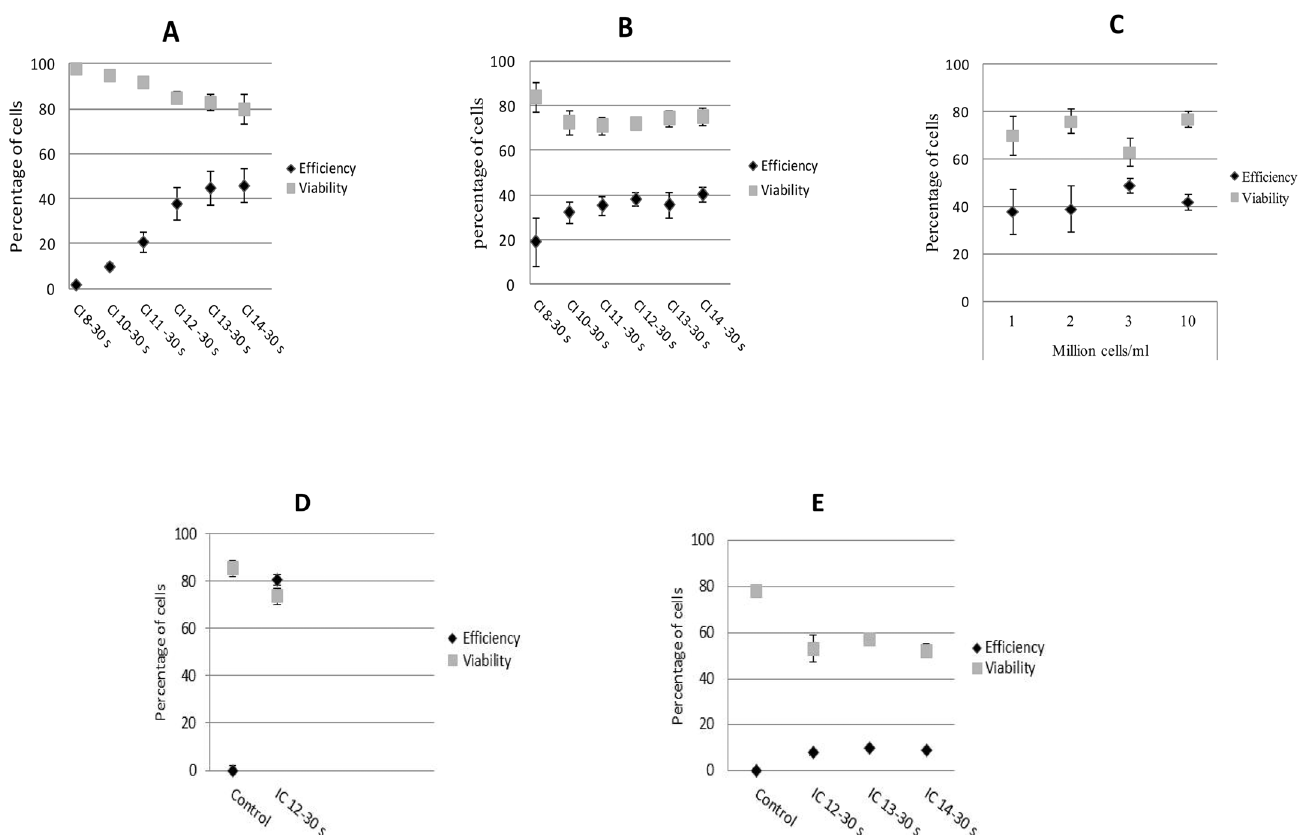
Fig 4. Influence of CI level and cell density on transfection efficiency and cell viability. Twenty-four hours post-sonoporation, the percentages of GFP- positive cells and levels of cytotoxicity were assessed by flow cytometry and PI staining. Two non-adherent cell lines Jurkat (A) and K562 (B) were exposed to CI values ranging between 8 and 14 during 30 seconds. The sonoporation with peGFP-C1 was performed in a 2 ml Eppendorf tube containing 10 μ g of pEGFP-C1 in 550 μ l of Opti-MEM medium. The cell concentration was set to 2.10 6 cells/ml. (C) Transfection of 10 μ g peGFP-C1 in Jurkat cells at four different cell densities (1.10 6 , 2.10 6 , 3.10 6 , and 10.10 6 cells/ml). Percentage of GFP-positive cells and dead cells were determined at different cell densities using CI of 12 for 30 seconds. (D) Transfection efficiency and cell viability of the A549 cell line (10 μ g peGFP-C1, 10.10 6 cells/ml, and CI 12 – 30 seconds). (E) Transfection efficiency and cell viability of fresh AML cells. The error bars represent the mean ( ± standard deviation, SD) of triplicates and two measurements for Figs A-D and E, respectively. doi:10.1371/journal.pone.0134247.g004 PLOS ONE | DOI:10.1371/journal.pone.0134247 August 14,